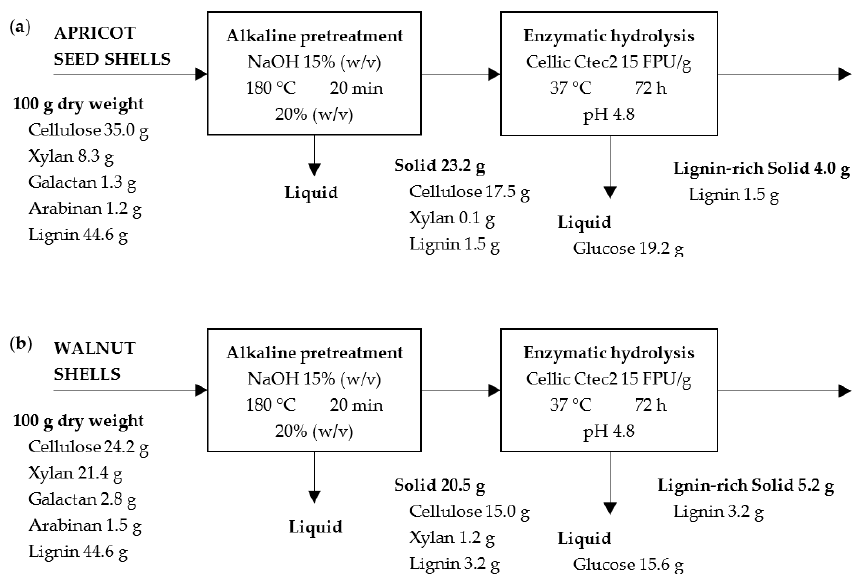
Figure 11. Mass balance for alkaline pretreatment and enzymatic hydrolysis of apricot seed shells ( a ) and walnut shells ( b ).